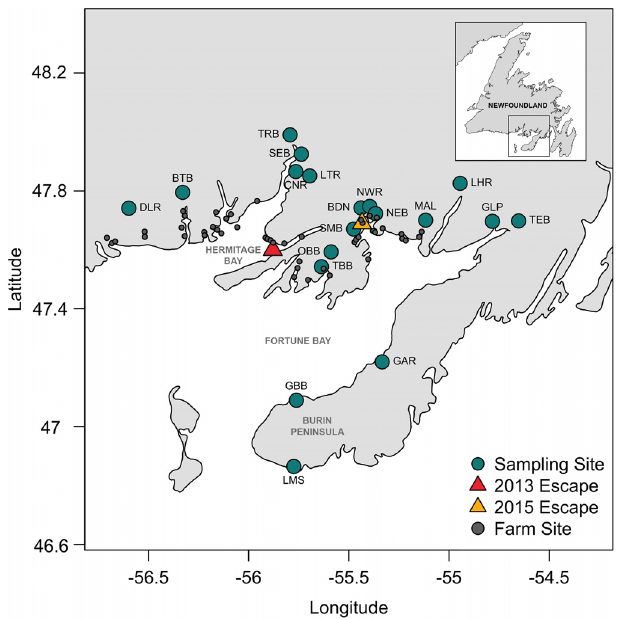
Fig. 1. Atlantic salmon parr sampling sites in southern New- foundland relative to the large 2013 escape event and smaller 2015 escape event. Farm sites indicate close proximity to wild salmon populations. See Table 1 for river